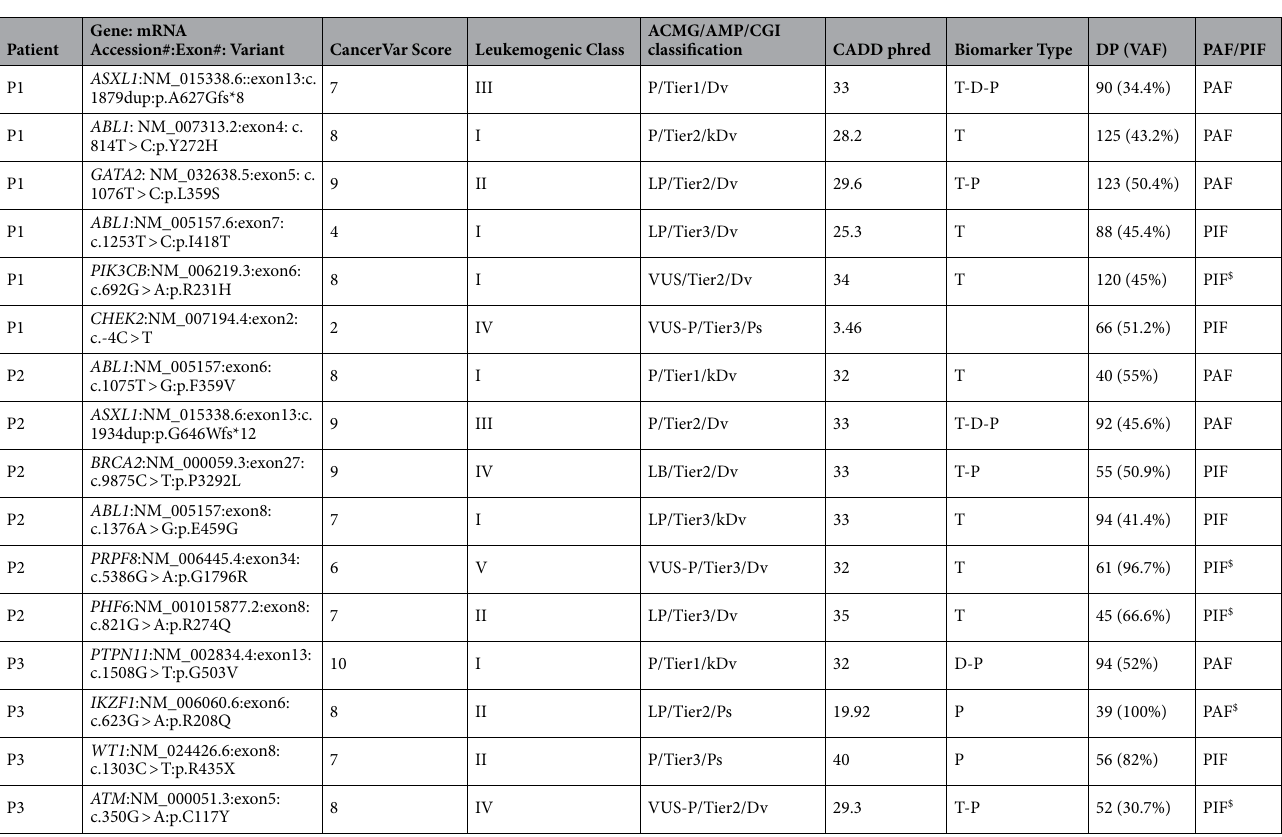
Table 3. Potentially actionable (PAF) and potentially important (PIF) findings in WES analysis of BC-CML patients. P pathogenic, LP likely pathogenic, VUS-B variant of uncertain significance leaning benign, VUS-P variant of uncertain significance leaning pathogenic, B benign, LB likely benign, TSG tumor suppressor gene, OG oncogene, Dv driver, kDv known driver, Ps passenger. Biomarker type: T = Therapeutic; D = Diagnostic; P = Prognostic; DP: Depth of coverage; VAF: Variant Allele Fraction. Leukemogenic Class: I (Signaling); II (Transcription Factor), III (Epigenetic Regulator); IV (TSG); V (Spliceosome). $ Novel variants in CML. Npa: not protein